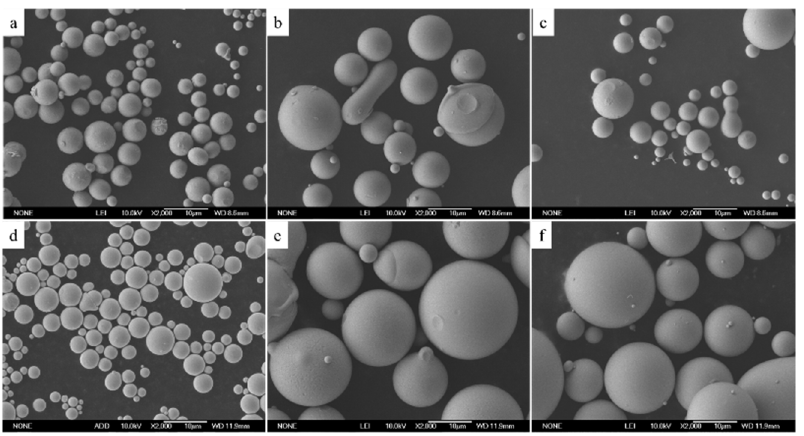
Figure 1. Morphology of atomized powder obtained at 1700 °C with different compositions (SEM).( a ) Sample 1; ( b ) Sample 2; ( c ) Sample 3; ( d ) Sample 4; ( e ) Sample 5; ( f ) Sample 6